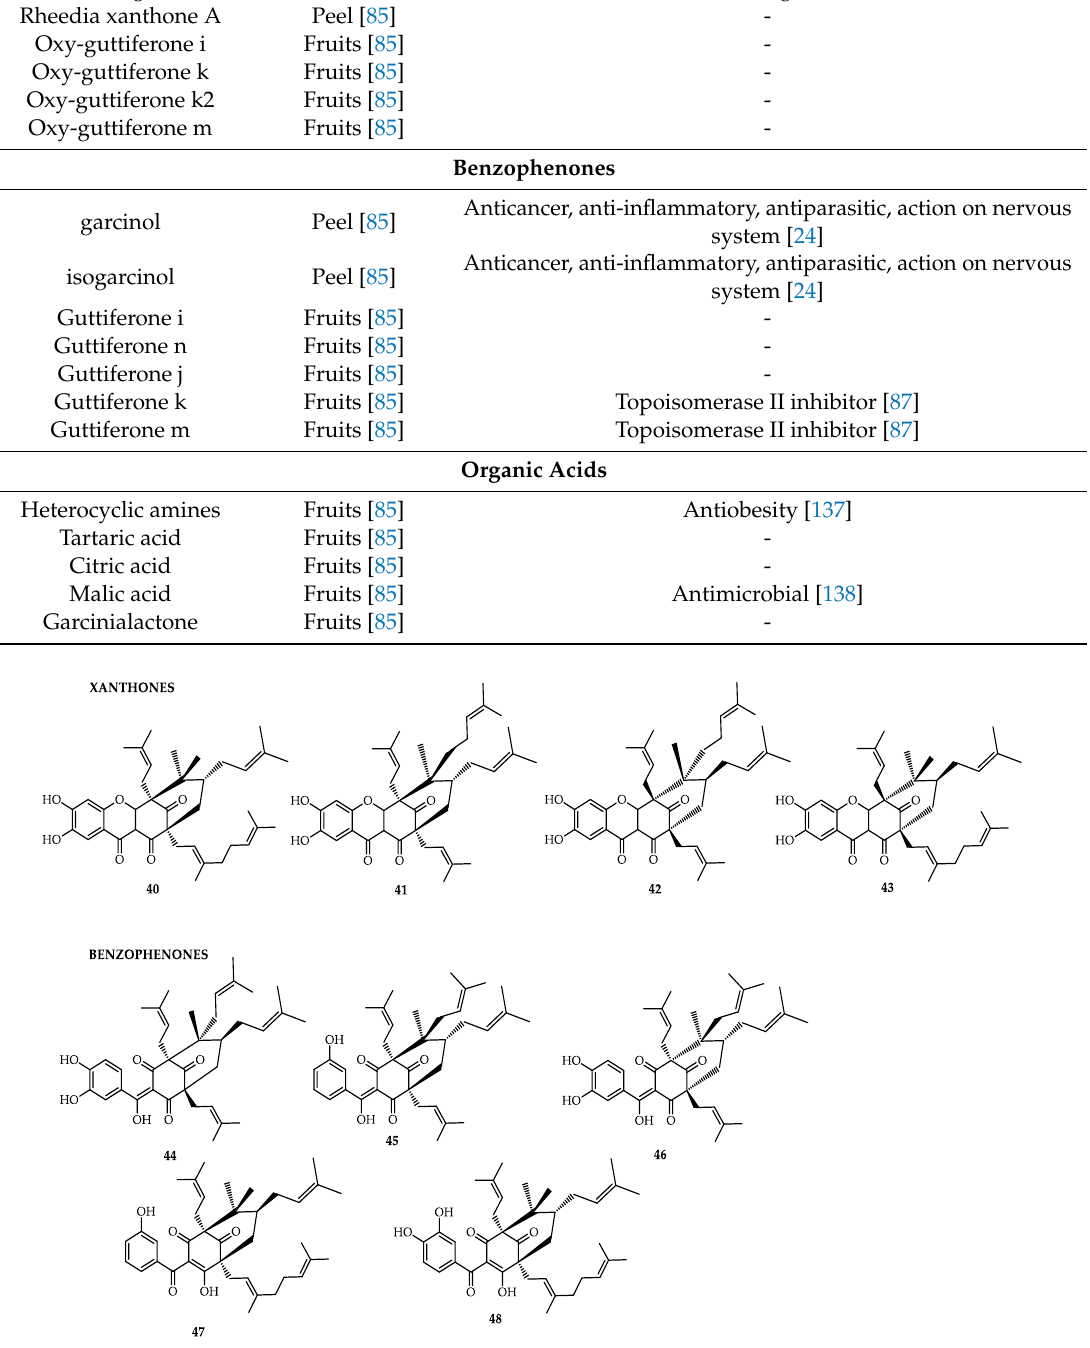
Figure 4. Bioactive compounds of Garcinia cambogia.